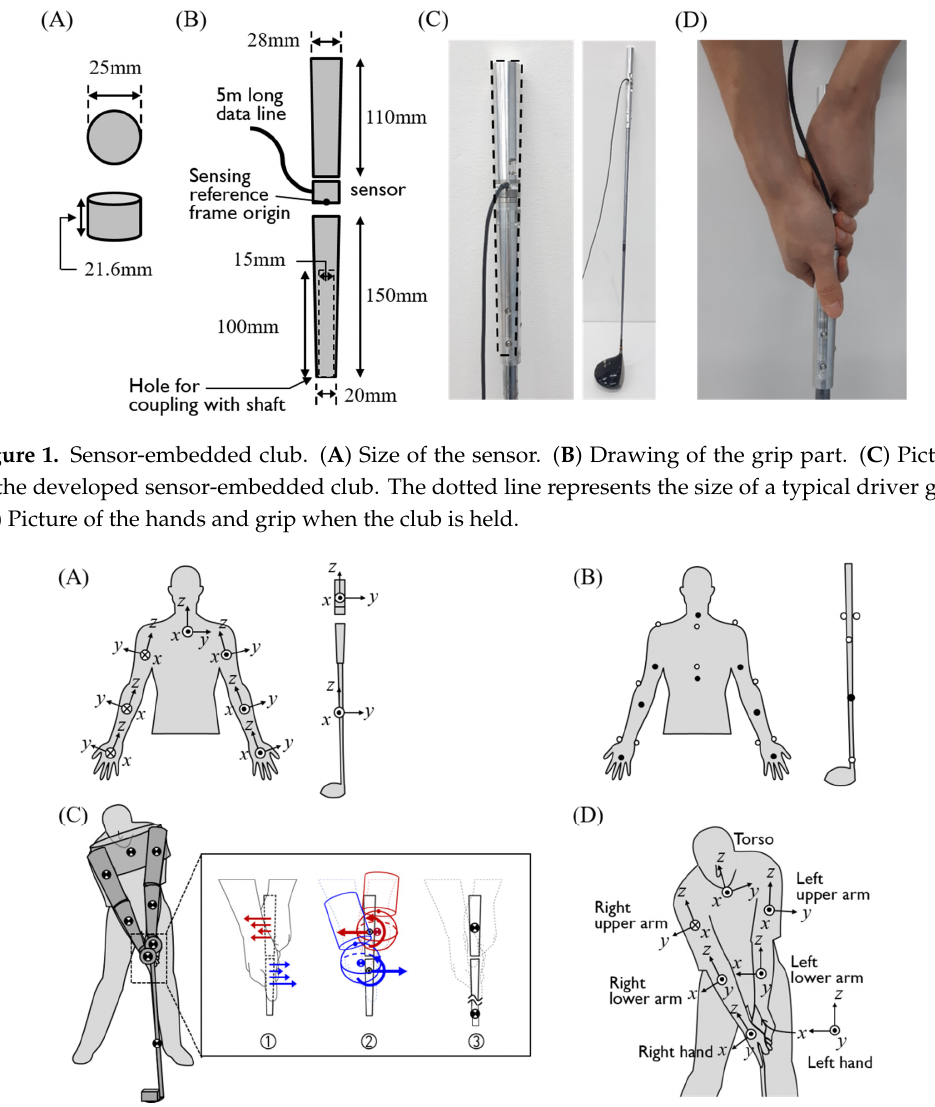
Figure 2. Three-dimensional upper limbs and club model for inverse dynamics analysis. ( A ) The local coordinate system of each segment. ( B ) Position of optical markers attached. White dots are markers attached to the front of the subject’s body, and black dots were attached to the back of the subject’s body. ( C ) The shape of the model. The inset shows the distribution of the force exerted on the club by both hands into the resultant force and torque in the inverse dynamics model, the shape of both hands, and the club segment. ( D ) The local coordinate system of each segment at the address posture. Table 1. Local axes of each segment.